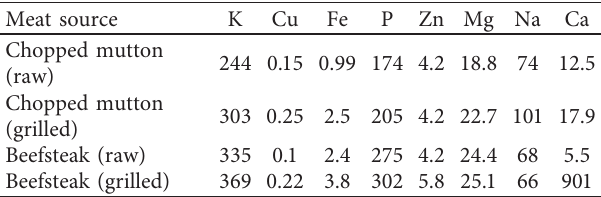
Table 3: Mineral contents (mg/100g) of meat and meat products. Meat source K